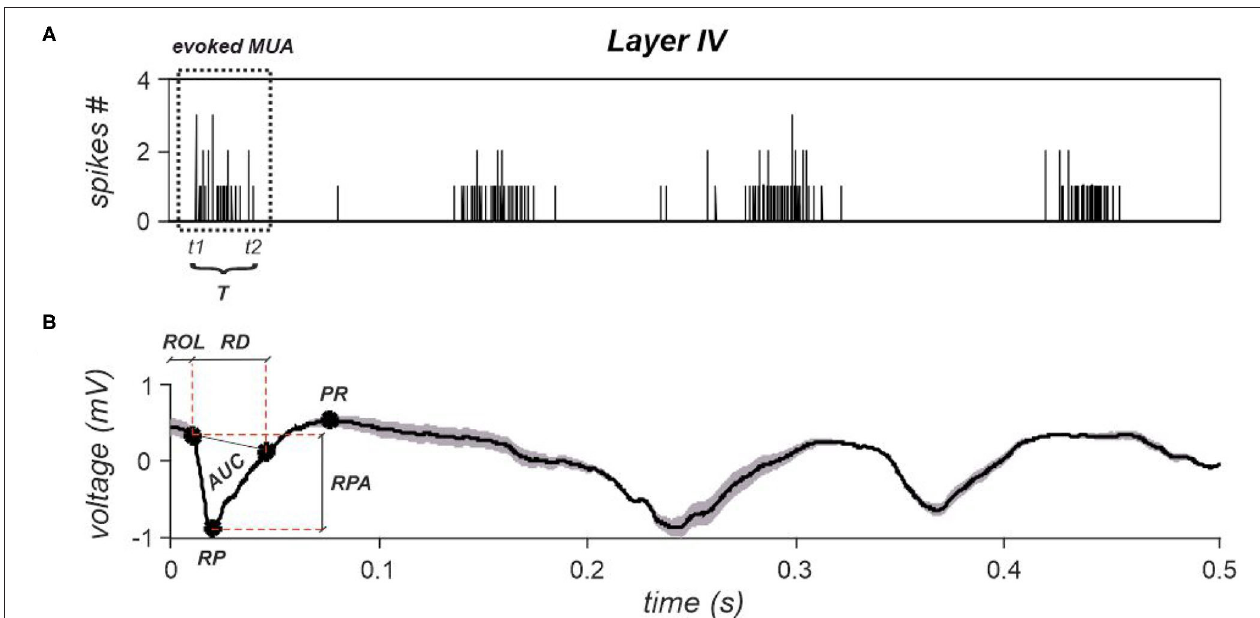
FIGURE 7 | (A) A cumulative spike train obtained by summing spikes detected from all electrodes belonging to layer IV. Time instant zero indicates stimulation’s occurrence. The evoked MUA is highlighted by a dotted rectangle, whose start and end are indicated as t1 and t2 . The duration, T is also reported. (B) A representative evoked LFP obtained by averaging all evoked responses observed within layer IV. The corresponding extracted features are reported, i.e., ROL , RPA , and PR . AUC and RD are the parameters necessary to compute the last investigated LFPs’ feature, i.e., tLFP . was composed of excitatory neurons and inhibitory